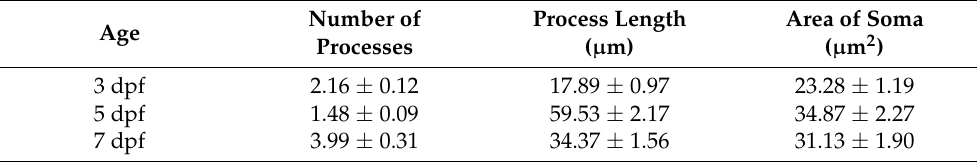
Table 1. Characteristics of radial glia cells during cerebellar development.